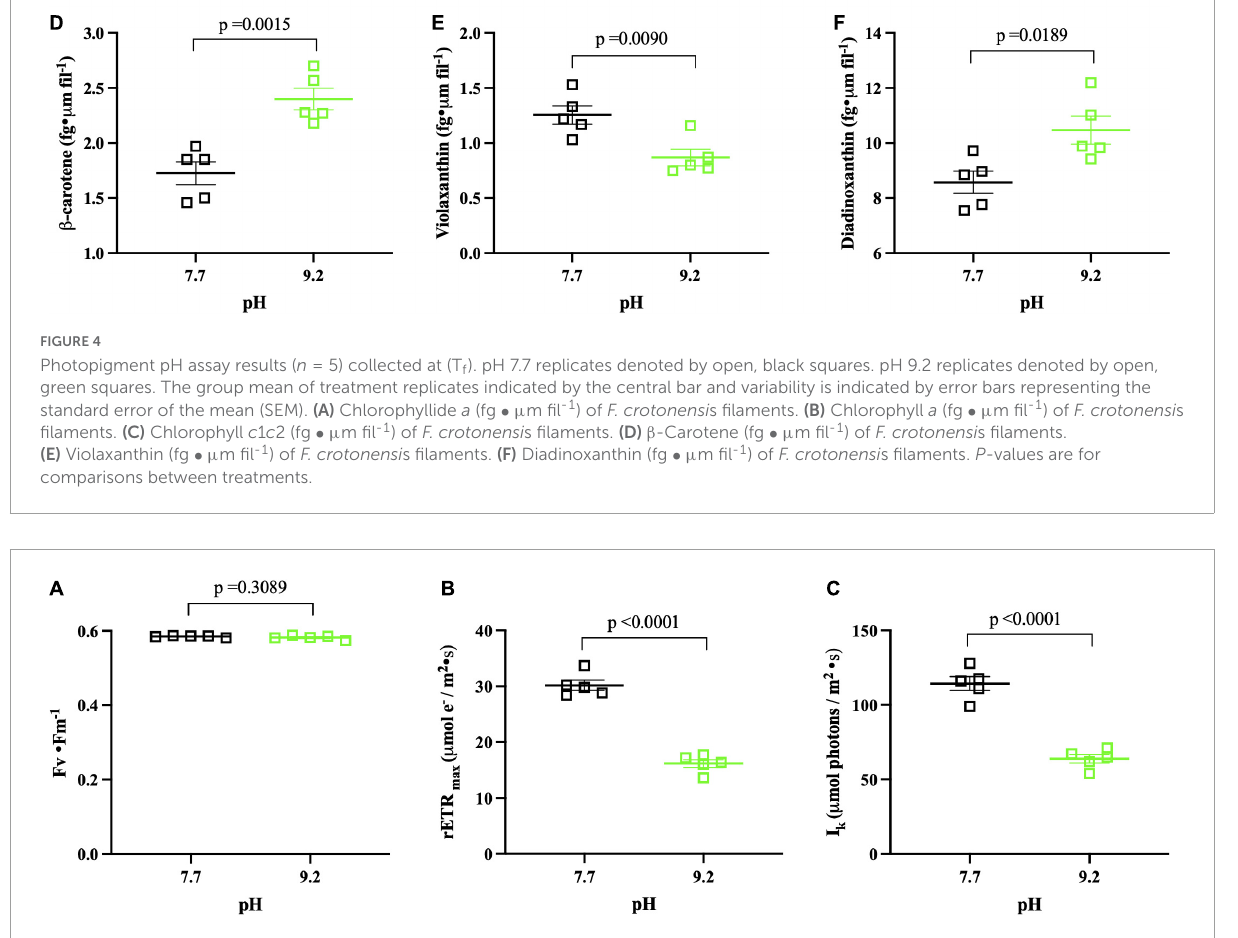
F. crotonensis may not have been exclusively carbon